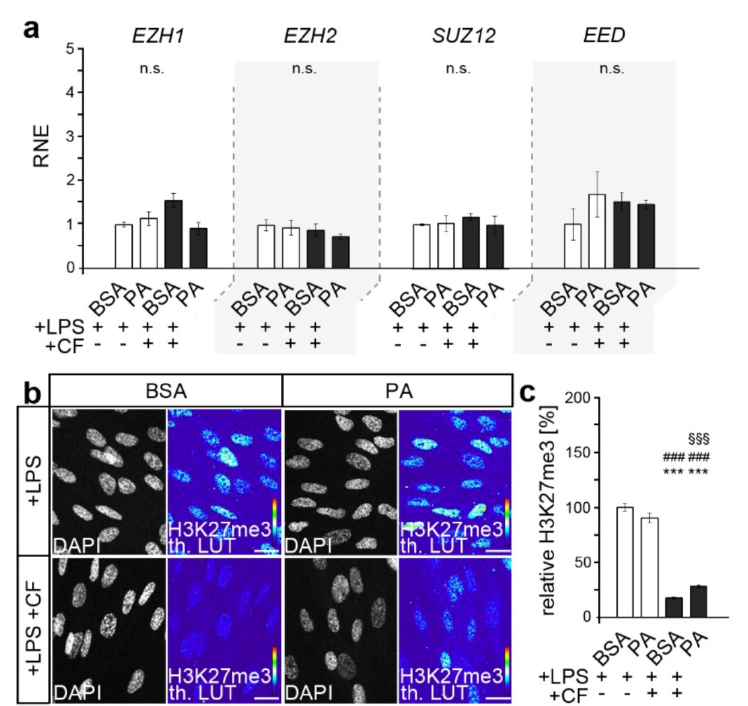
Figure 2. K27 trimethylation in response to dual stimulation was minor in PA-exposed HPdLFs. ( a ) Quantitative expression analysis of genes encoding components of the polycomb repressive complex ( EZH1 , EZH2 , SUZ12 and EED ) in human periodontal ligament fibroblasts (HPdLFs) exposed to palmitic acid (PA) and simultaneously stimulated with compressive force (CF) and P. gingivalis LPS and compared to the BSA+LPS controls. ( b , c ) Representative microphotographs of global H3K27me3 of HPdLFs under previous conditions. H3K27me3 staining intensity is shown as thermal LUT (th. LUT) in ( c ) in relation to BSA+LPS control. DAPI indicates the nuclei. *** p < 0.001 in relation to BSA+LPS; ### p < 0.001 in relation to PA+LPS; §§§ p < 0.001 in relation to BSA+LPS+CF; n.s., no significant difference between the conditions. One-way ANOVA and post hoc test (Tukey) were used for analysis. Scale bars: 10 µ m in ( b